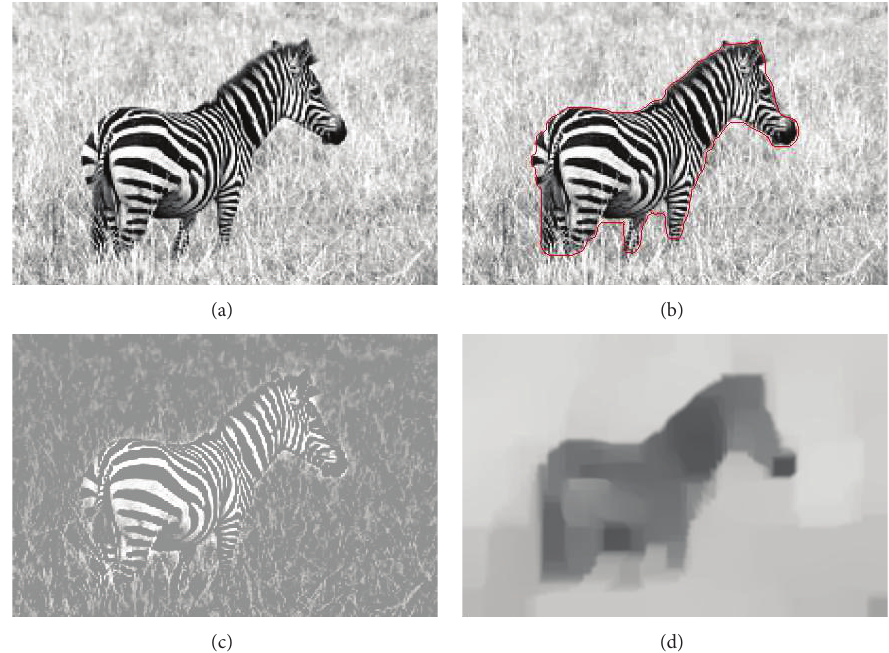
Figure 4: Image for segmentation: (a) original zebra image; (b) the segmentation result; (c) the textural part of the image; (d) the structural part of